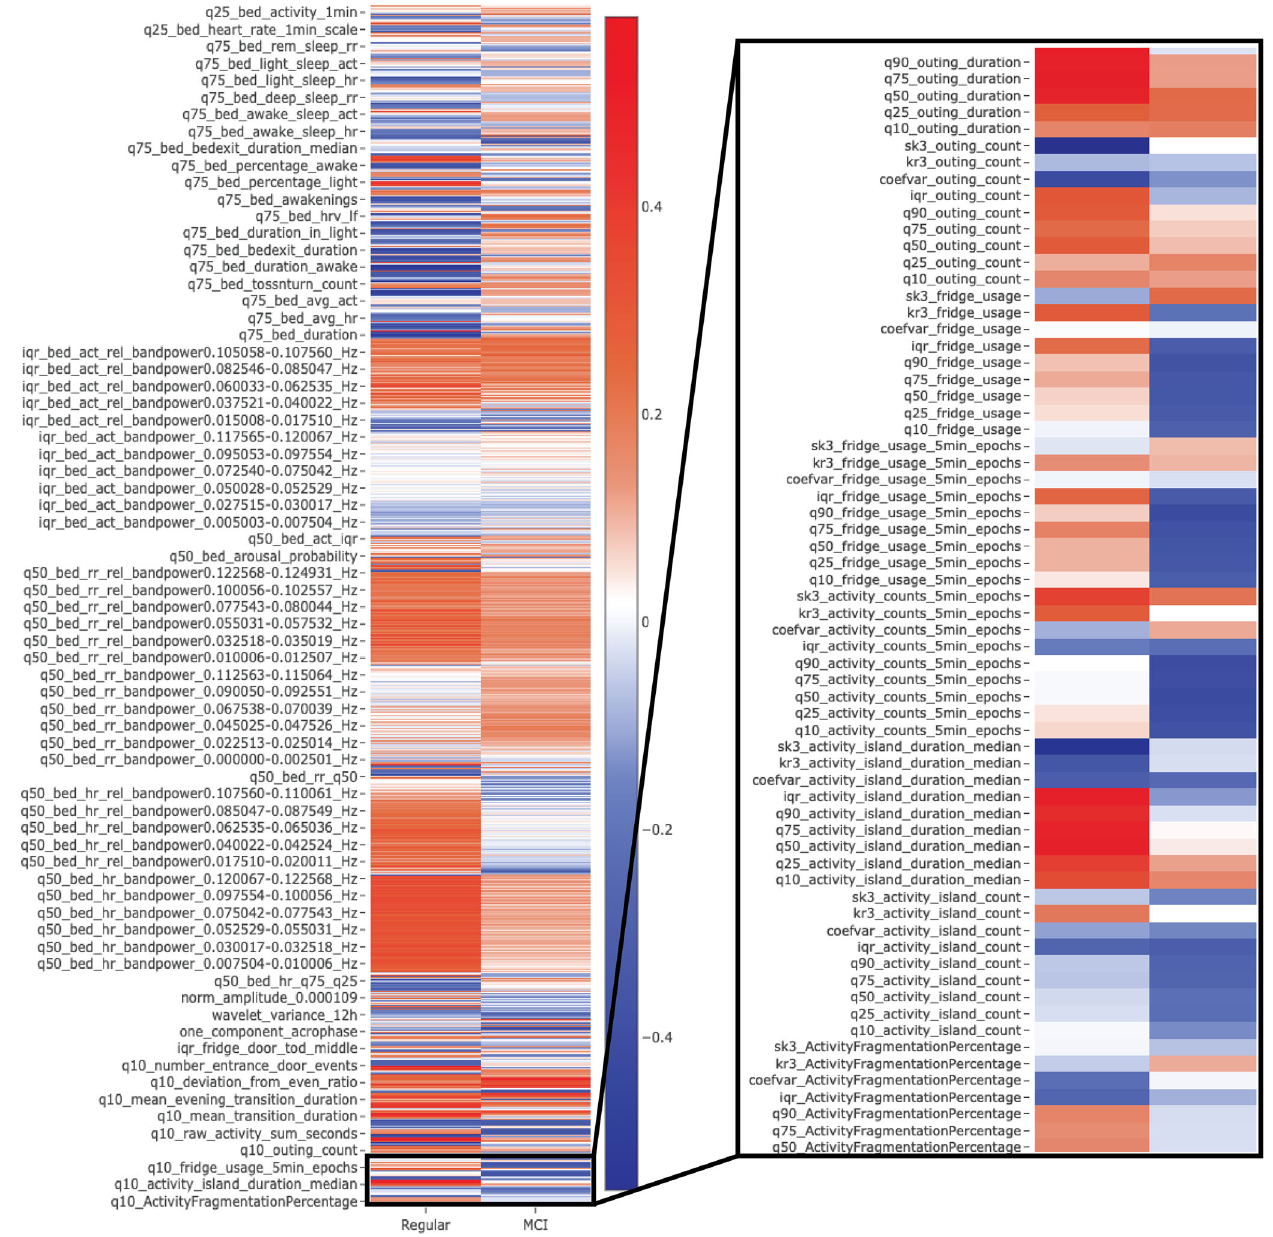
Fig. 1 Exemplary visualizations of averaged digital exhausts. Depicts an example of z-normalised, averaged digital exhausts of participants with mild cognitive impairment (MCI) (based on a Montreal Cognitive Assessment screening < 23 points). Digital measures > 0 (in blue) indicate above-average values for that group, while < 0 (red) indicates below-average values. Many digital measures visually differ in both examples. It should be noted that this is a down-scaled visualisation, as not all measures would fi t in the fi gure. For the complete and interactive version, see the supplementary online version (Note the zoom-in